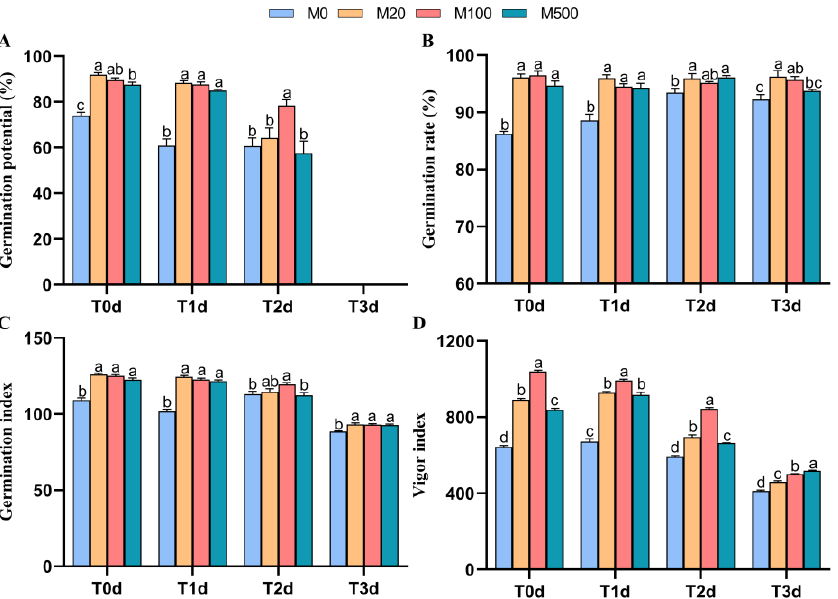
Figure 1. Effects of melatonin and flooding stress on germination potentials ( A ), germination rates ( B ), germination indices ( C ), and vigor indices ( D ). Different letters represent statistically significant differences ( p < 0.05).